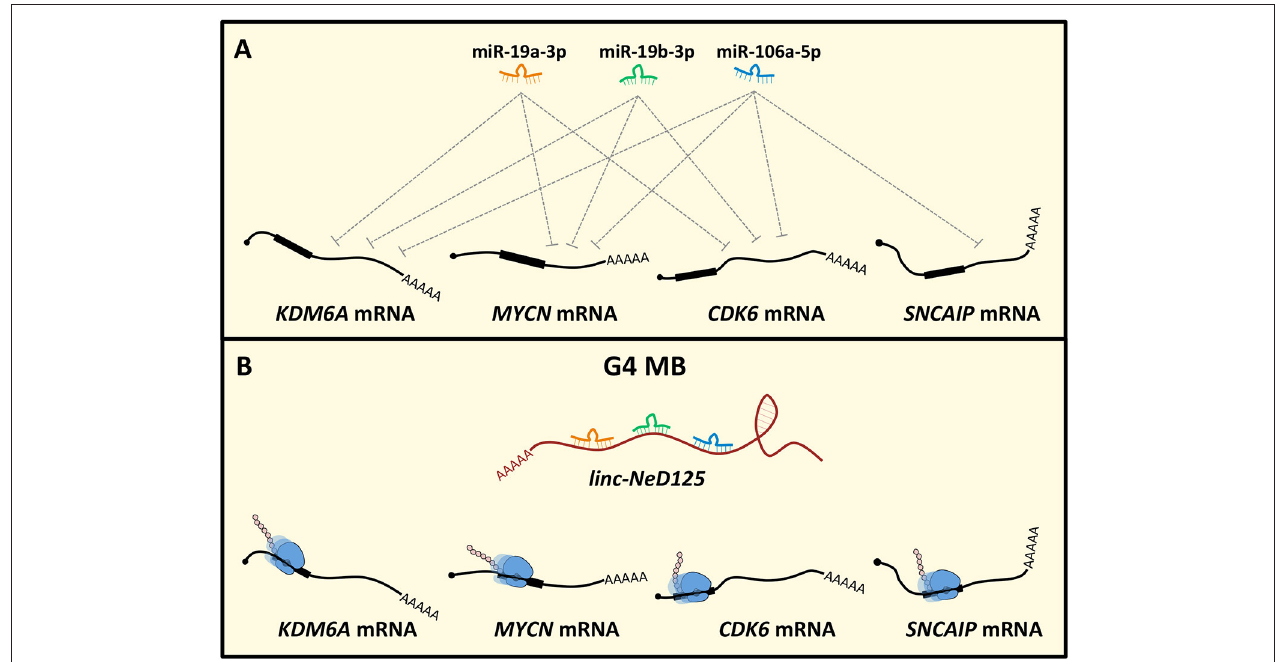
FIGURE 2 | Linc-NeD125 -based network in MB. (A) MiR-19a-3p, miR-19b-3p, and miR-106a-5p pleiotropically control KDM6A , MYCN , CDK6 , SNCAIP gene expression. (B) In G4MB, linc-NeD125 is upregulated and, functioning as a decoy for the three miRNAs, causes translational derepression of the G4MB driver genes KDM6A , MYCN, CDK6 , SNCAIP